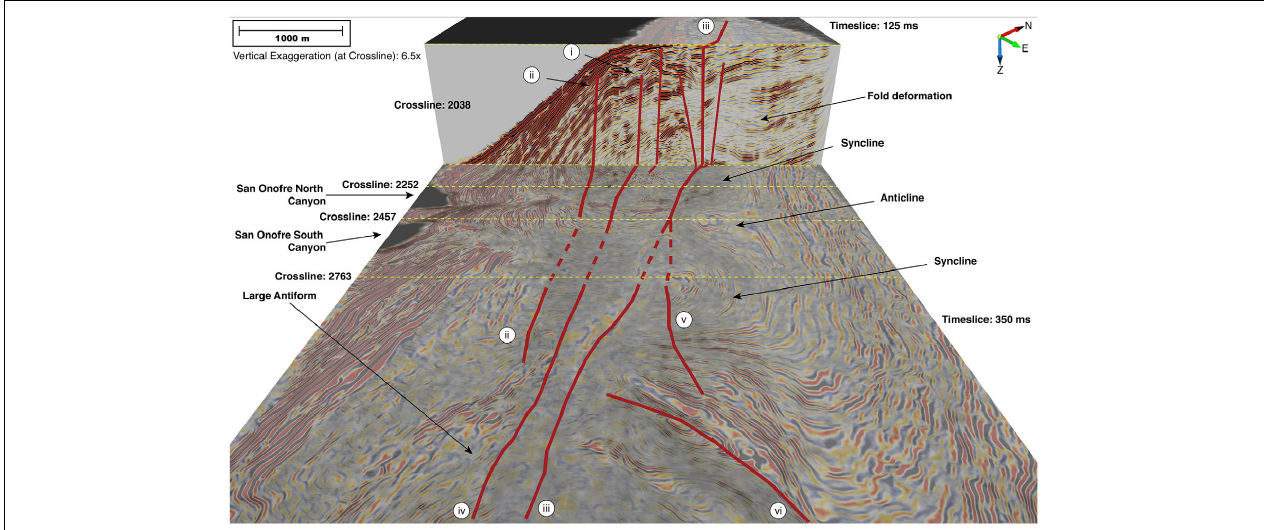
FIGURE 5 | Stair diagram of crossline 2038 with interpreted faults shown with solid red lines. Location relative to the survey area, is shown in Figure 1C . Faults are dashed where there is acoustic transparency, which introduces uncertainty. Fault plane of segment vii has terminated and been replaced with fold deformation. Sediment from northeast is laminar and acoustically transparent until fault segment iii. Reflector amplitude is visibly more prominent on southwestern side of segment iii.